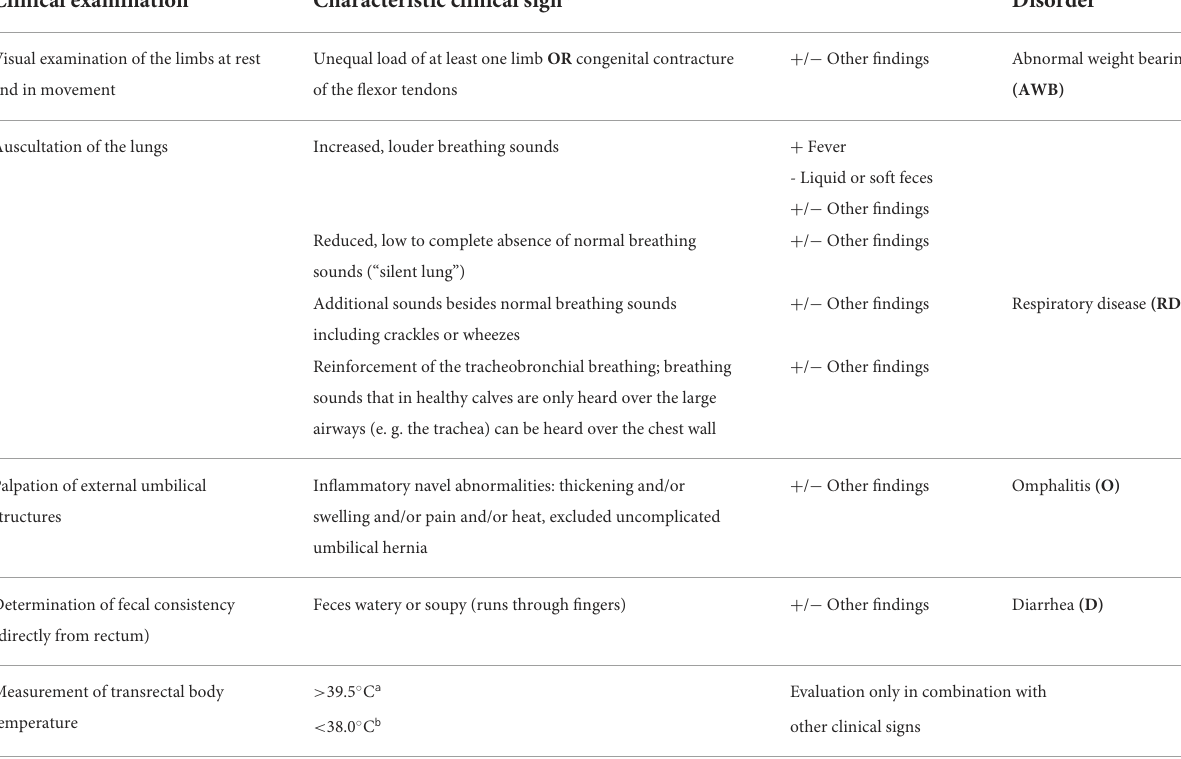
TABLE 6 Case definition of disorders based on characteristic clinical signs detected in the clinical